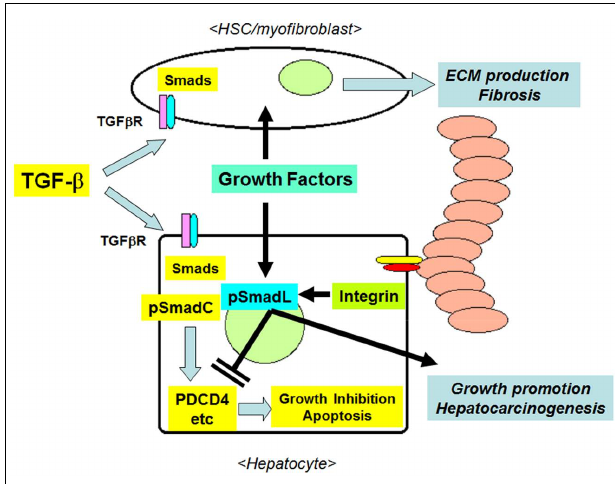
FIGURE 4 |The interactions betweenTGF- β 1 and ECM/integrin-mediated signaling in hepatocytes in the fibrotic liver. Initially,TGF- β 1 inhibits the growth of hepatocytes by inducing the expression of pro-apoptotic molecules, such as PDCD4, via the formation of pSmadC.TGF- β 1 stimulates the production of fibrous ECM from activated HSCs/myofibroblasts.The accumulated ECM proteins in turn activate integrins, then these activated integrins and co-existing growth factors inhibit theTGF- β 1-induced growth-suppressive signals via the formation